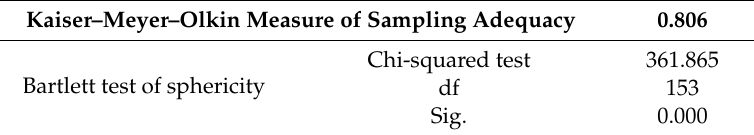
Table 3. The Kaiser–Meyer–Olkin measure and Bartlett’s test of FA